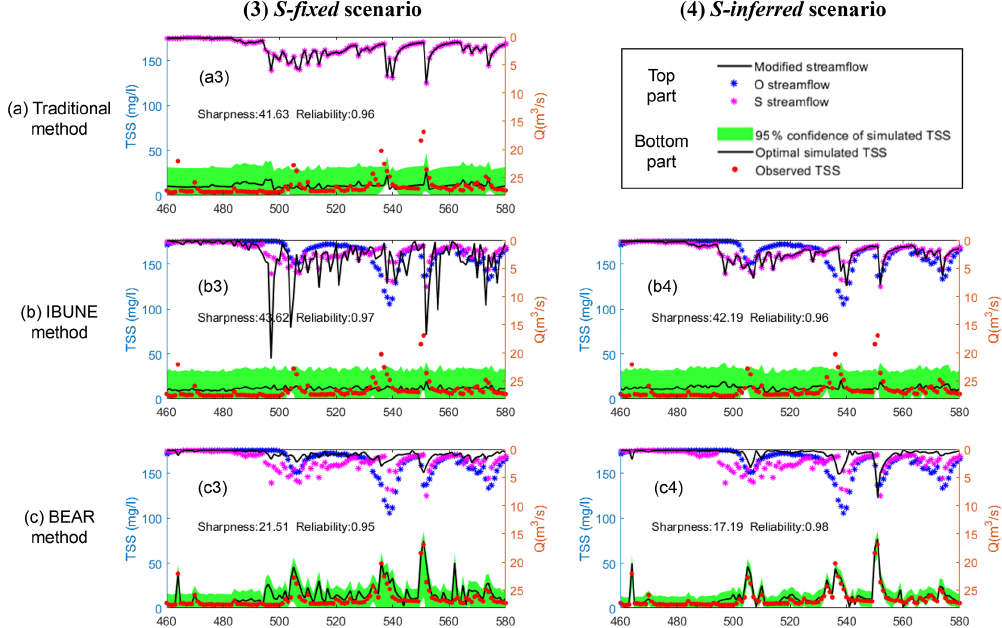
Figure B6. Comparison of the time series of synthetic data and uncertainty bands estimated via three calibration methods (including the traditional method, the IBUNE method, and the BEAR method; algorithms are explained in Sect. 2.4) for a select period of the S -fixed and S -inferred scenarios in the real case (notations are given in Table